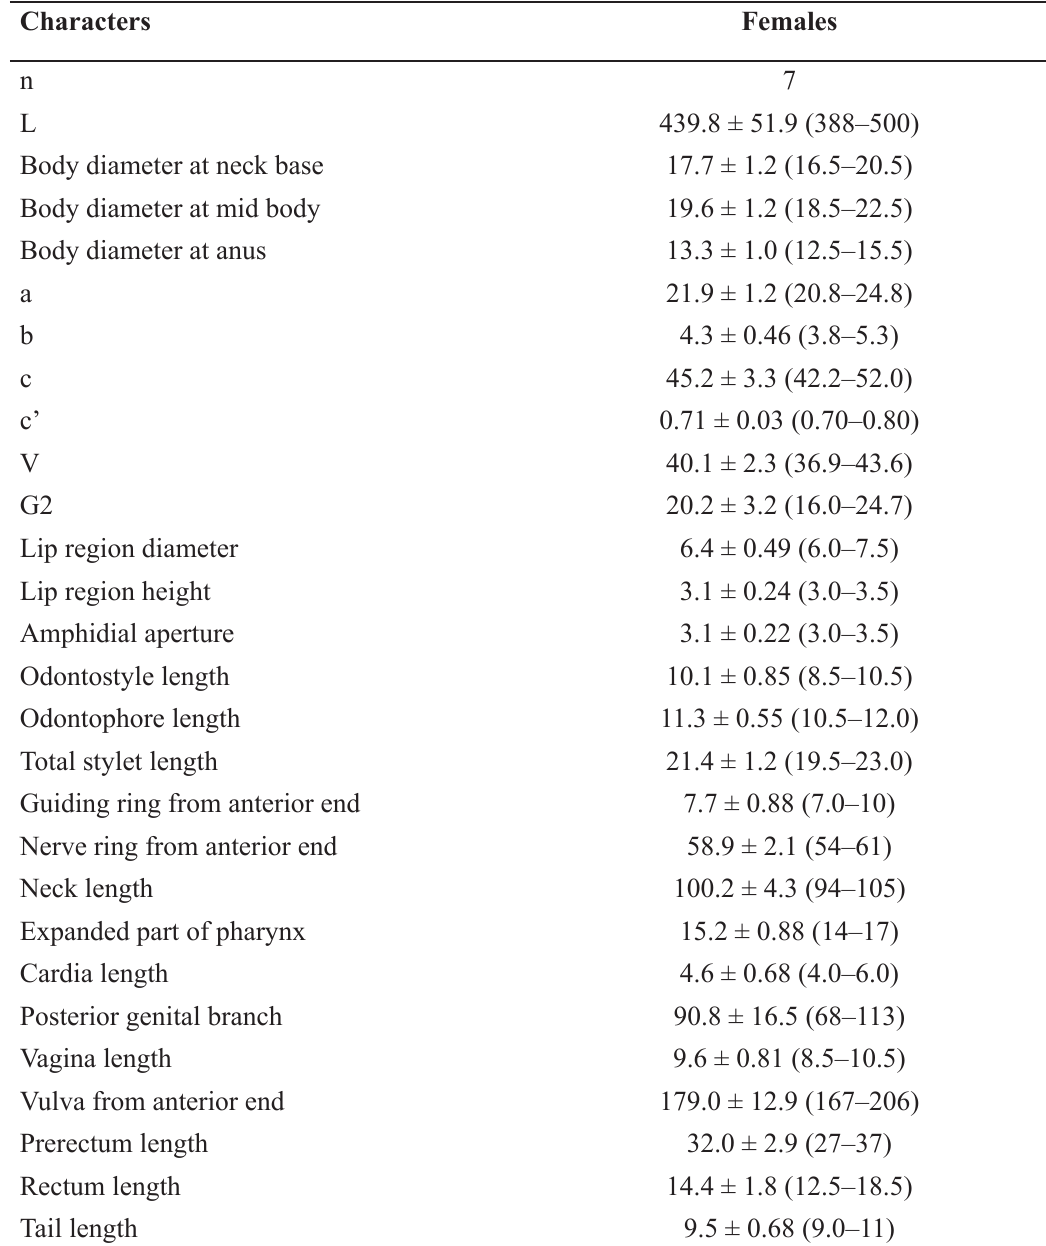
Table 4. Measurements of Basirotyleptus ethiopicus Siddiqi, 1970. All measurements are in μm and in the form: mean ± s.d.